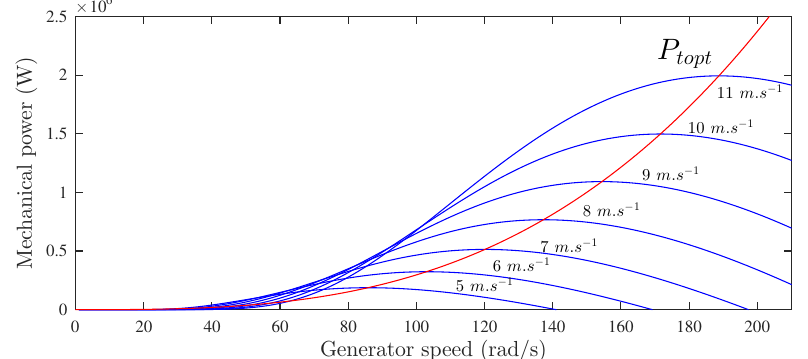
Figure 3. Mechanical power as a function of the generator speed and wind